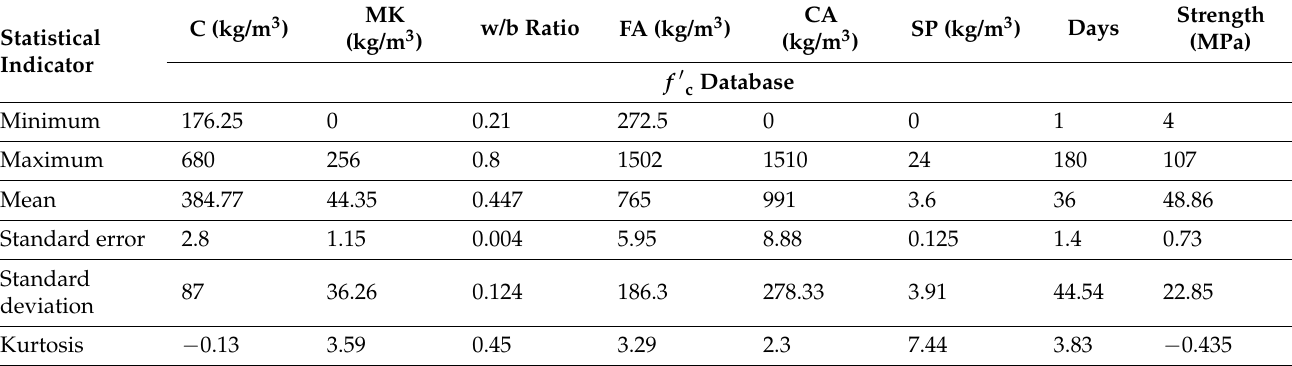
Table 1. Descriptive statistics of input and output variables used in the training